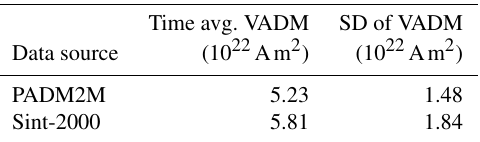
Table 2. Average reversal rate and standard deviation computed over the past 30Myr using the chronology of Ogg